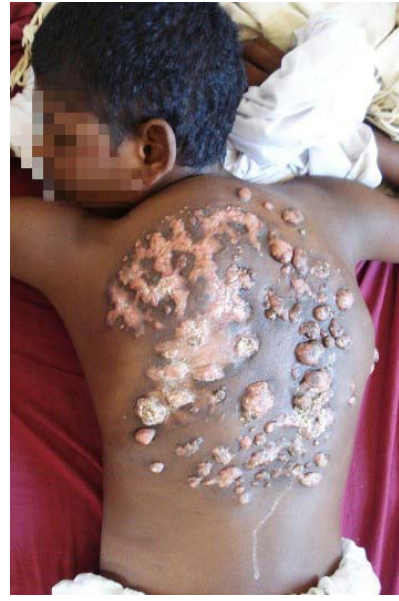
Figure 6. Massive back actinomycetoma with multiple nodules and sinuses.